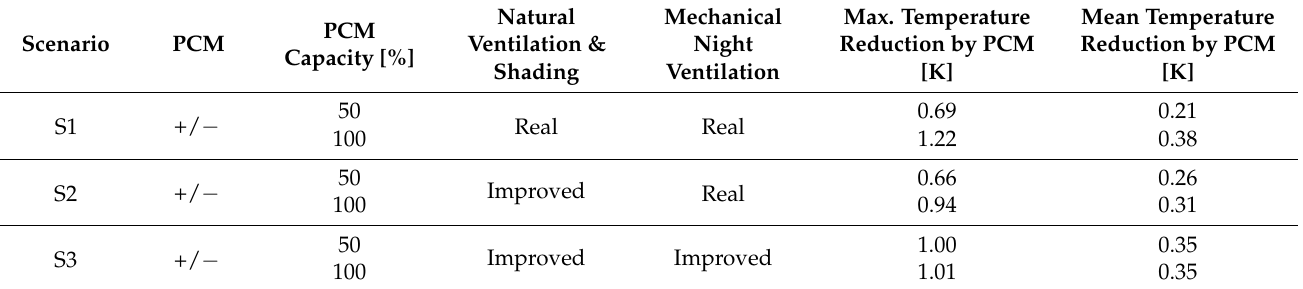
Table 3. Simulation results of different behavioural scenarios and influence of PCM for the office room. Temperature reductions indicated are due to PCM scenario (+) compared to scenario without PCM ( −